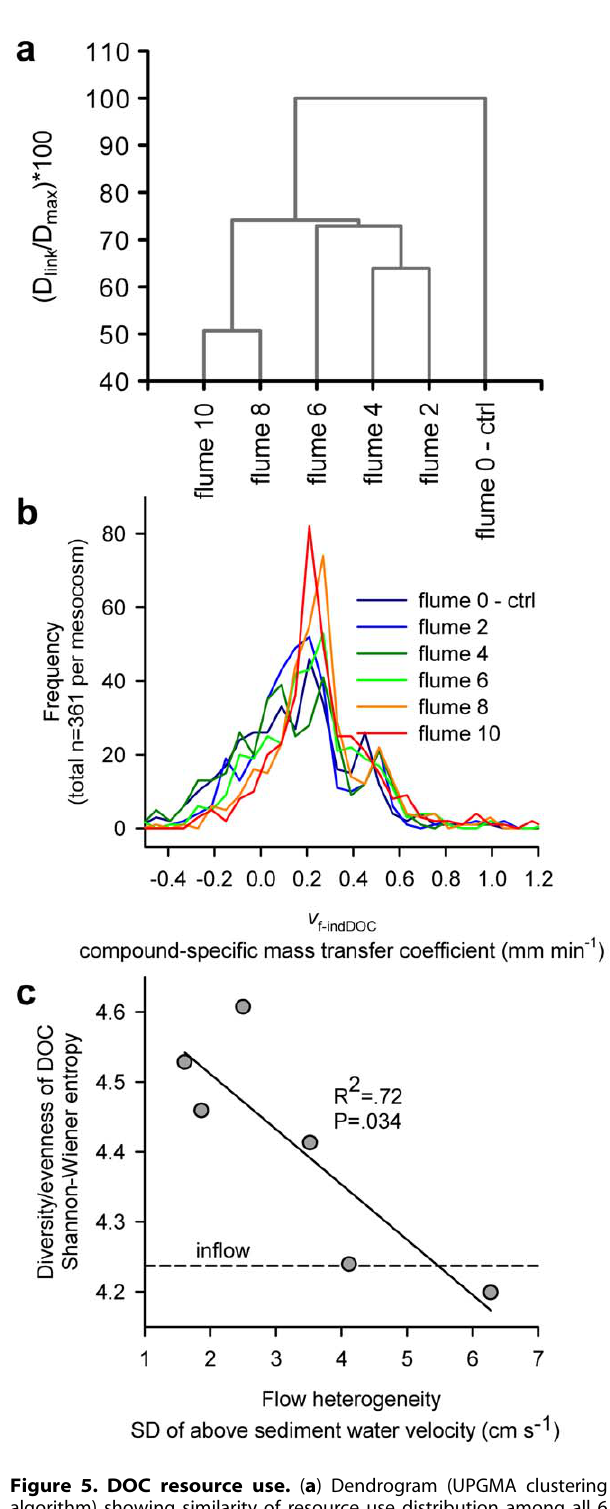
Figure 5. DOC resource use. ( a ) Dendrogram (UPGMA clustering algorithm) showing similarity of resource use distribution among all 6 flumes with increasing flow heterogeneity (height of bedforms in cm). An Euclidean distance matrix was calculated from normalized mass transfer coefficients of 361 DOC compounds present in all residual (after recirculation) and inflow samples. ( b ) Frequency distributions of compound specific mass transfer coefficients (n=361) in all 6 flumes. ( c ) Shannon-Wiener diversity/evenness of the molecular composition of the residual DOC pool. Note the similar evenness of the inflow (dashed line) and residual DOC pools in the high-heterogeneity landscapes. The